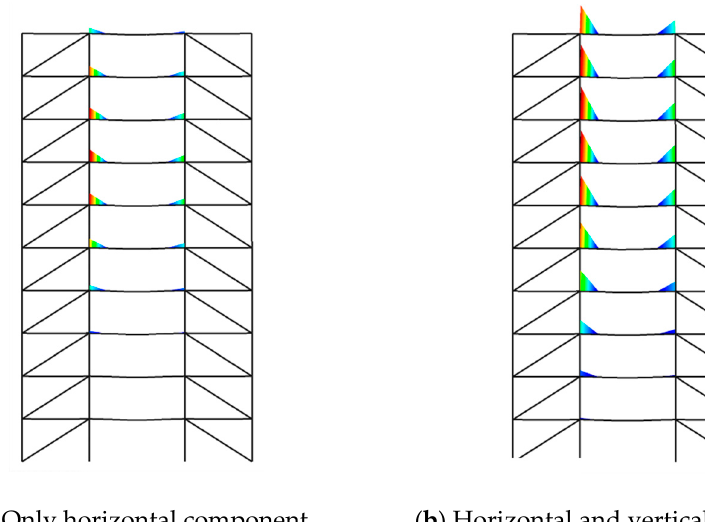
Figure 12. Plastic hinges for earthquake SCRU at the end of the seismic register. The red/blue color in the color contours indicates higher/lower degree of plastic rotation.